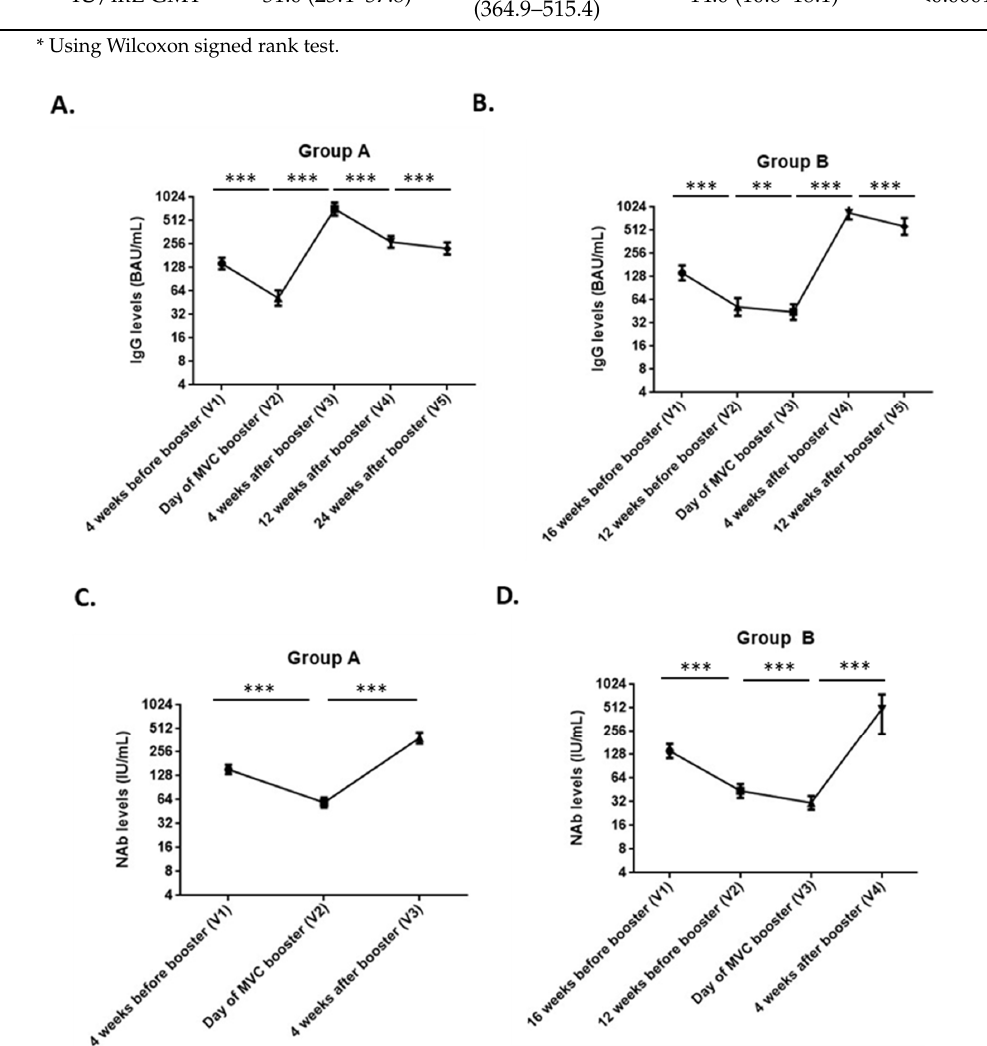
Figure 3. Anti-SARS-CoV-2 spike IgG titers (in BAU/mL) and neutralizing antibody (nAb) titers (in IU/mL) at different time points for both groups A and B. The results were presented by line graph with bars representing geometric mean IgG and nAb titers with error bars for 95% confidence interval values. The following graphs are featured in the figure ( A ) IgG titers in BAU/mL for group A from V1 to V5; ( B ) IgG titers in BAU/mL for group B from V1 to V5; ( C ) nAb titers in IU/mL for group A at different time points; and ( D ) nAb titers in IU/mL for group B at different time points. Comparisons between two consecutive time points were made using Wilcoxon signed-rank test (** p < 0 .05, *** p < 0.01). Table 3. Immunogenicity on the day of MVC-COV1901 booster (V2 for Group A, V3 for Group B) and one month after MVC-COV1901 booster (V3 for Group A, V4 for Group B) as measured by anti- SARS-CoV-2 spike IgG titers and live virus neutralizing antibody titers. GMTs are shown as GMT with a 95% confidence interval in the parentheses. Fold changes are calculated as the geometric mean of the V3/V2 ratio (for Group A) or V4/V3 ratio (for Group B) of individual titer values with a 95% confidence interval in the parentheses. Group A